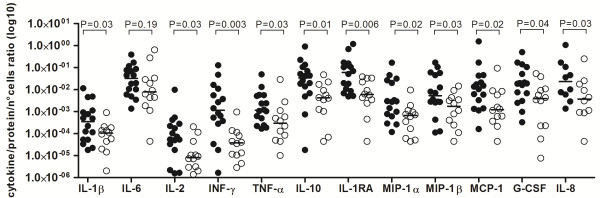
Ratio between cyto/chemokines and the number of PMN cells during infection. Each value of cyto/chemokine was individually divided per amount of cells. During pneumococcal meningitis (● ) cells demonstrated higher ability to release cyto/chemokines than meningococcal meningitis (○). IL-8 shows a lower number of samples due to CSF availability.